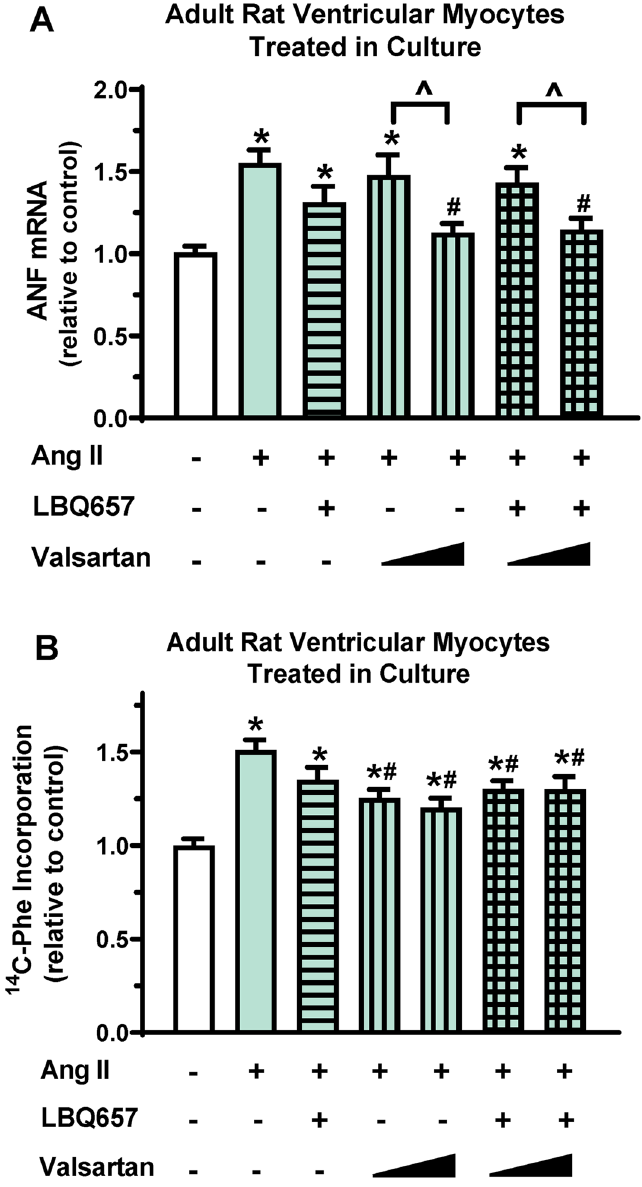
Figure 3. Sacubitril/valsartan has a modest effect on Ang II-induced adult ventricular myocyte hypertrophy in culture. Adult rat ventricular myocytes were pretreated with LBQ657 (10 µM), valsartan (0.3 or 1 µM) alone or the combination of LBQ657 (10 µM)/valsartan (0.3 or 1 µM) for 1 h before Ang II stimulation (1 µM, 72 h). Ang II and drugs were replaced every 24 h in myocyte treatments. ( A ) ANF mRNA expression normalized to 18S and expressed relative to vehicle controls (open bar, without Ang II, valsartan, and LBQ657). n = 9 determinations per group. ( B ) 14 C-Phenylalanine incorporation normalized to cell numbers and expressed relative to vehicle controls. n = 10–12 determinations per group. Mean ± SEM. * P < 0.05 versus Control; # P < 0.05 versus Ang II; ^ P < 0.05 Valsartan at 1 µM versus 0.3